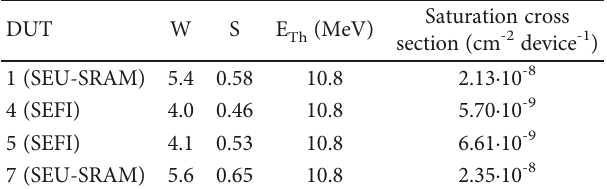
Table 1: CoolRunner-II proton irradiation results. Weibull fi tting parameters.